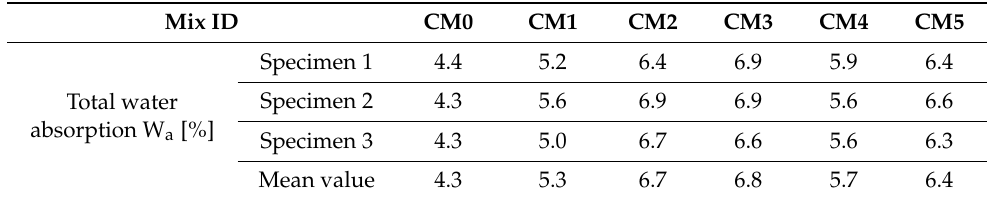
Table 9. Total water absorption of samples with WBA and control mix.